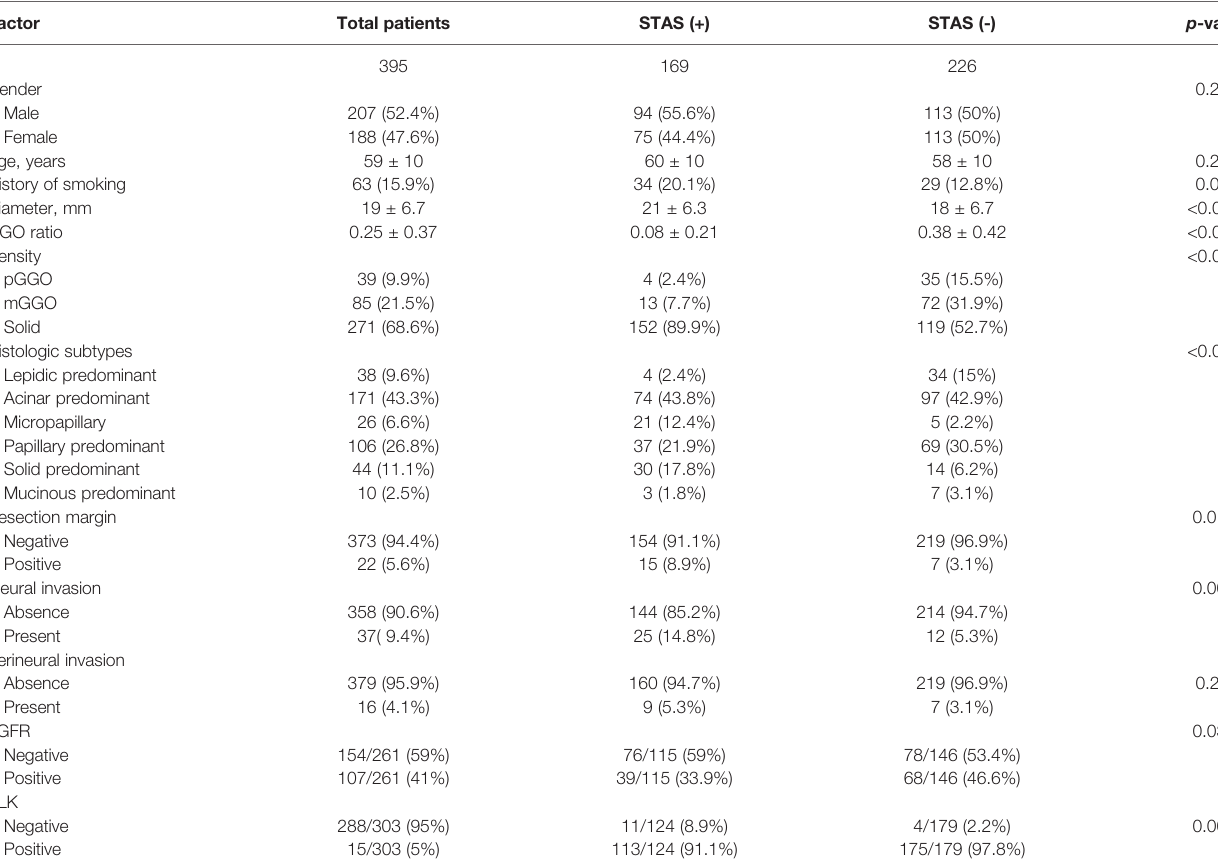
TABLE 1 | Associations of spread through air spaces with Clinicopathological features and CT fi ndings.